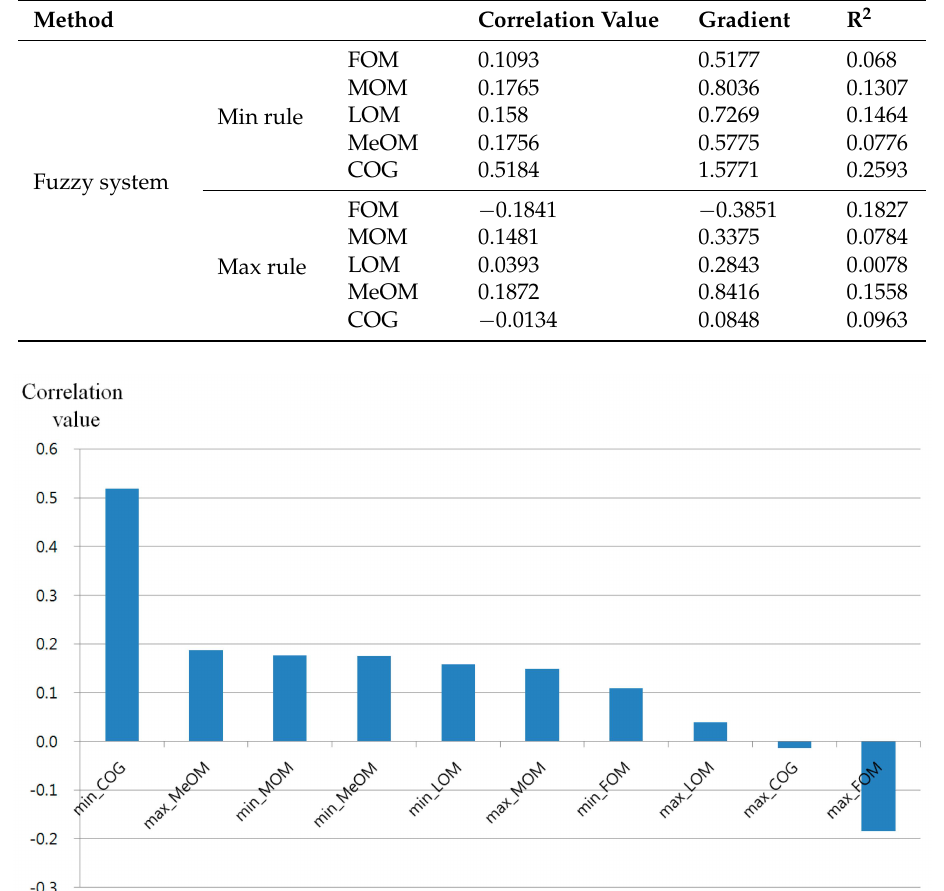
Table 4. The correlations between the real gaze tracking errors and the estimation values for each method of defuzzification using the Min or Max rule.